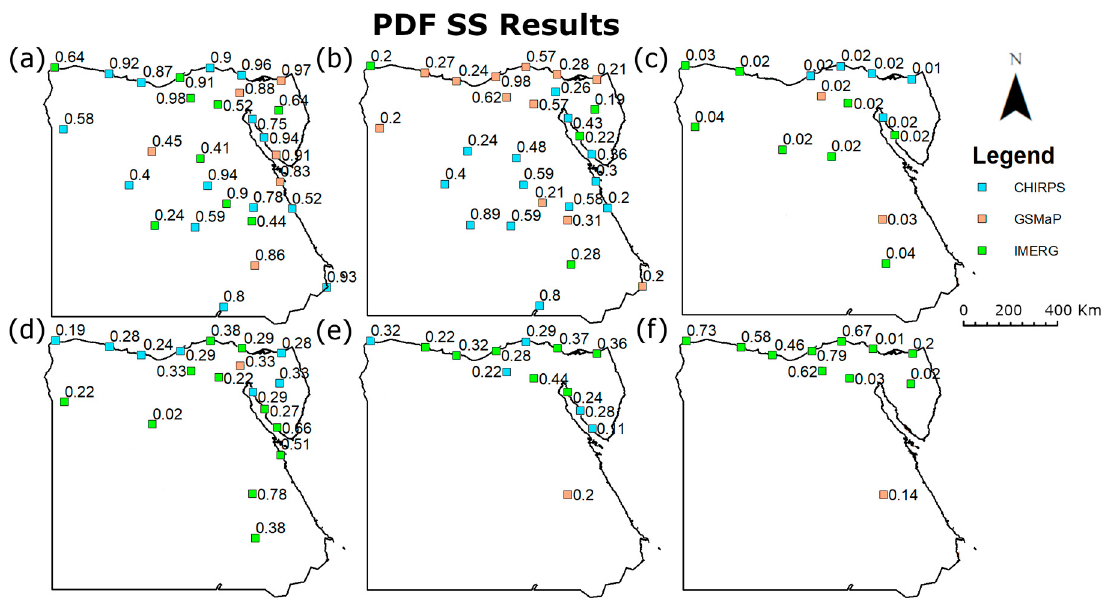
Figure 9. Maps showing the best performing datasets according to PDF SS at each station along with the estimated SS for best performing satellite rainfall product for ( a ) all rainfall events, ( b ) no/tiny rain, ( c ) light rain, ( d ) low–moderate rain, ( e ) heavy–moderate rain, and ( f ) heavy